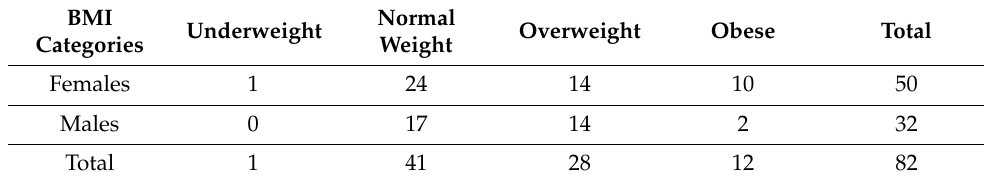
Table 2. BMI categorization of the study participants.